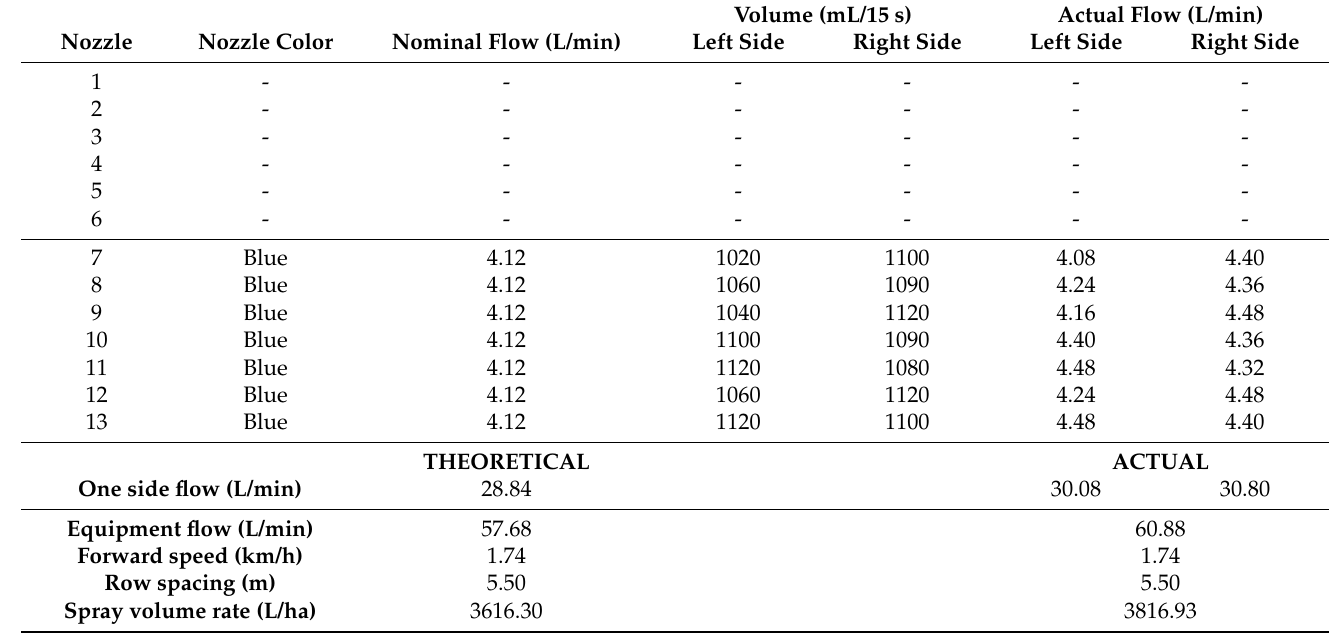
Table A20. Selection and calibration of nozzles for the C1 sprayer, with the following configuration: No adjusted to the vegetation/High & Low fan speed/High spray volume rate/Conventional nozzles (Fine)/Pressure: 15